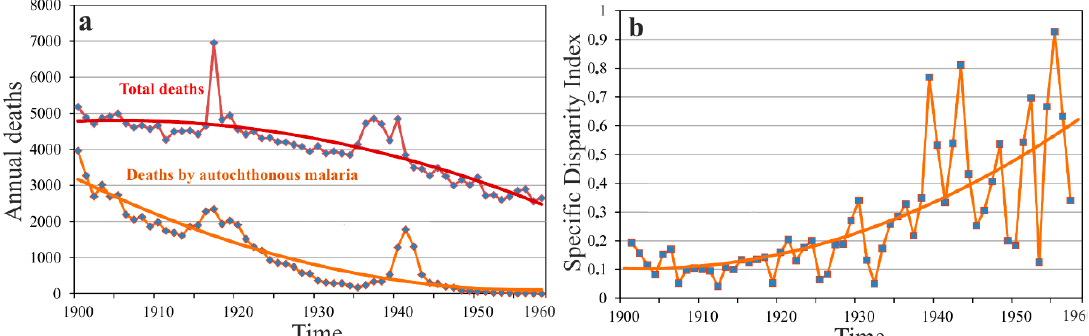
Figure 1. ( a ) Evolution of total number of deaths by autochthonous malaria with respect to absolute number of deaths in Spain in the 20th century. Total number of deaths is represented as a quotient of 100, to allow a comparison between tendencies. ( b ) Evolution of specific disparity index of mortality by autochthonous malaria in Spain for the 20th century.